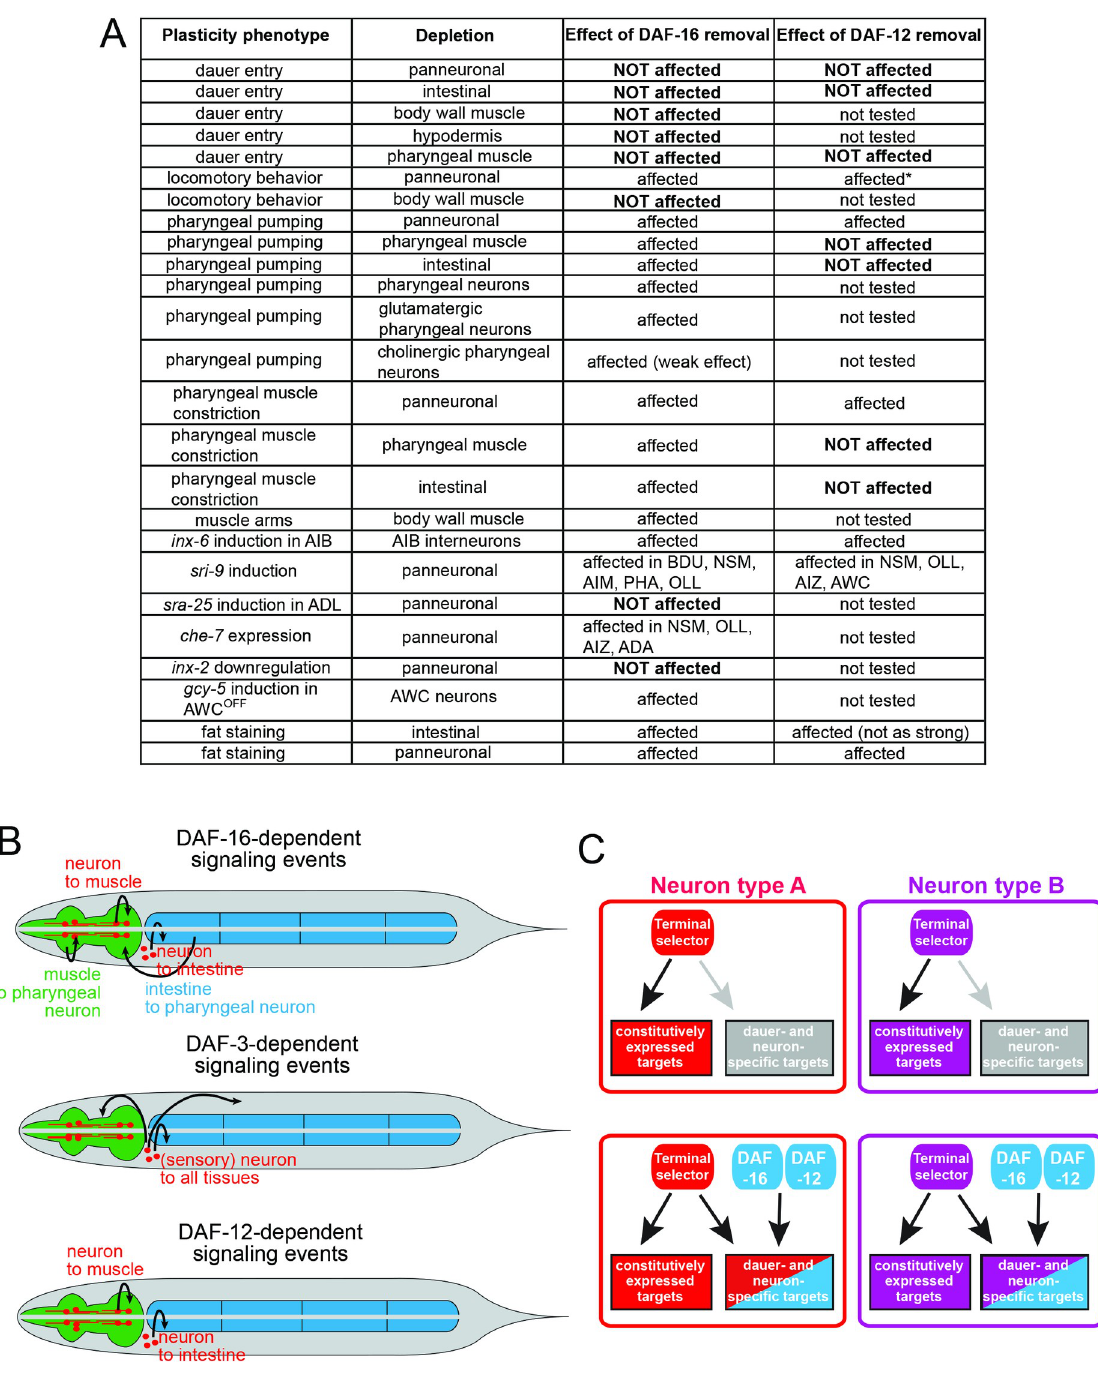
Fig 14. Summary and conceptual models. ( A ) Tabular summary of phenotypic outcomes of tissue-specific depletion of DAF-16/FoxO and DAF-12/VDR. ( B ) Models of inter-tissue signaling during dauer remodeling. (C) Terminal selectors control the expression of many immutable phenotypic features of a neuron, but are also enabling hormone-responsive TFs (DAF-12 and DAF-16) to induce dauer-specific target genes (e.g., inx-6 in AIB or gcy-6 in AWC). Future experiments will determine whether these interactions occur on the level of the cis- regulatory control elements of dauer specifically induced genes. One could envision that these control elements are tuned to not be responsive to either transcriptional input alone (terminal selector, dauer-specific TF), but requiring them both together. Since DAF-12 is commonly thought to act as a repressor in its unliganded form [25], these interactions may also be indirect. Not shown here is a variation of this model that may explain how DAF-16 may act to control the down-regulation of specific, dauer-repressed genes. Those could be under control of a terminal selector in non-dauer stage animal, but DAF-16 may antagonize its ability to activate these genes(s) upon entry into the dauer stage. https://doi.org/10.1371/journal.pbio.3001204.g014 PLOS Biology | https://doi.org/10.1371/journal.pbio.3001204 April 23,